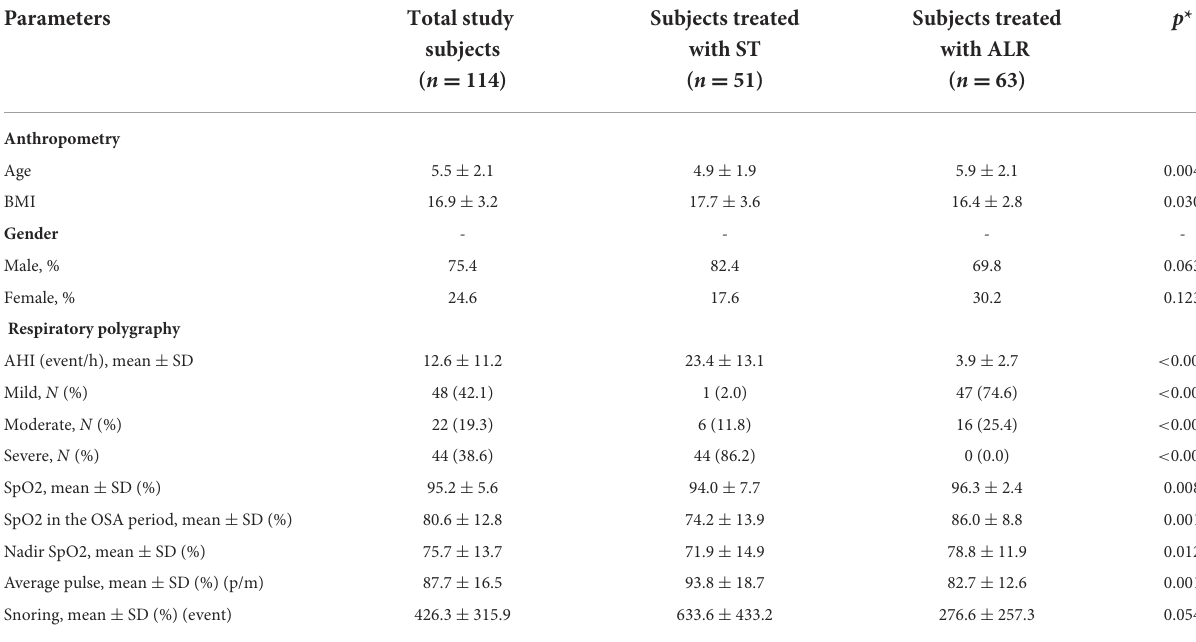
TABLE 2 Anthropometric and respiratory polygraphy characteristics of study subjects classified by treatments. Parameters Total study